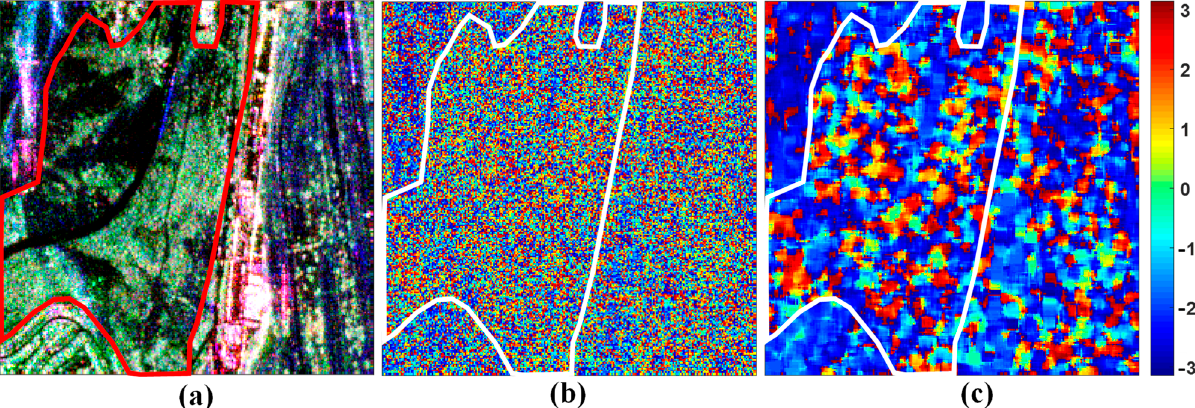
Figure 9. The original PauliRGB image ( a ), the original ( b ), and the Boxcar filtered ( c ) interferograms between the 9th and 1st acquisitions of ROI (250 × 250 pixels). The lowly coherent natural area is marked by the irregular box in Figure 9a–c.